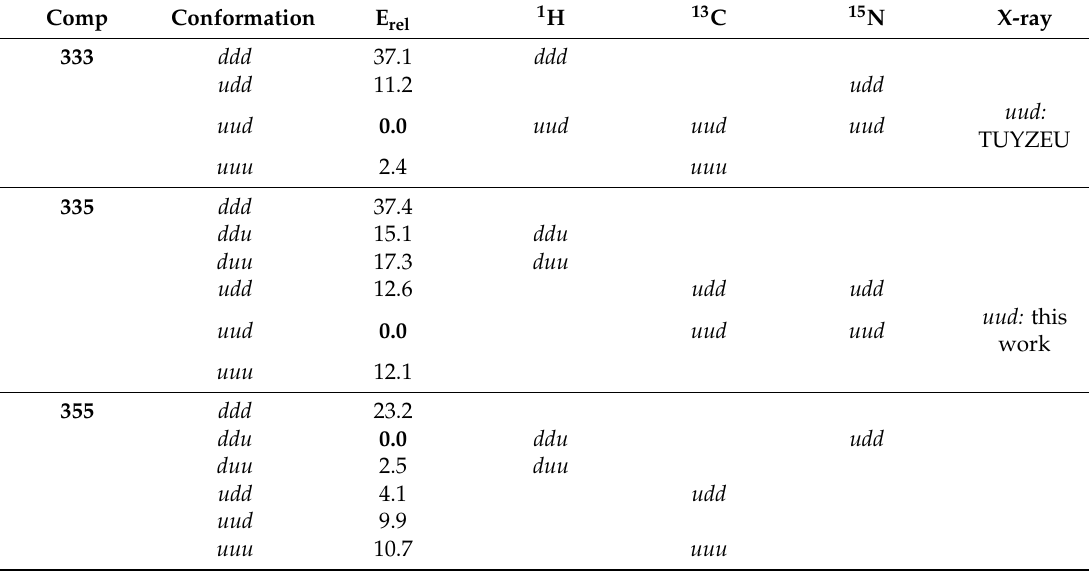
Table 3. Best conformers according to the method. 1 H in CDCl 3 ; 13 C and 15 N in C 6 D